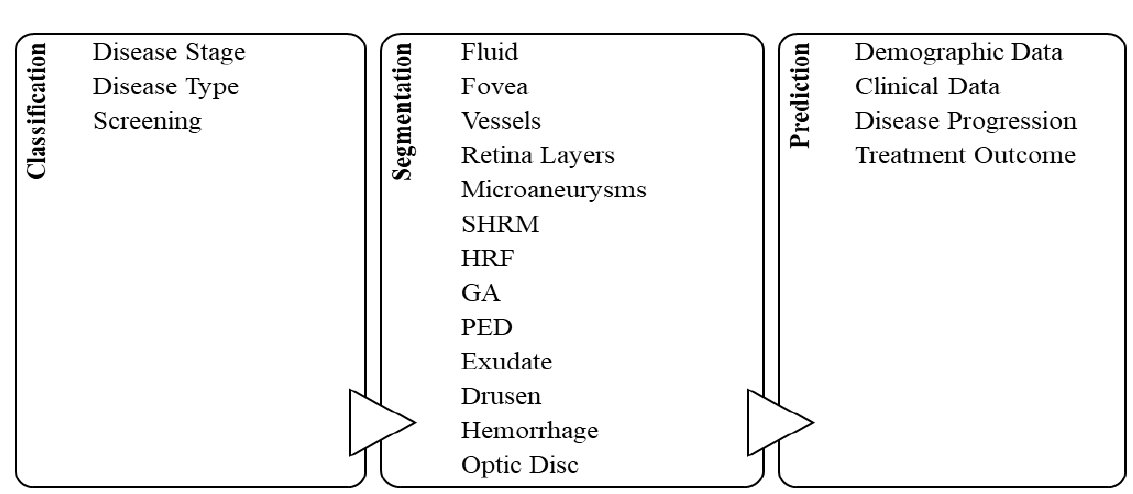
Figure 4. Application of AI in Retina Images [5] (Subretinal hyperreflective material (SHRM), Geographicatrophy (GA), hyperreflective foci (HRF), pigment epithelial detachment